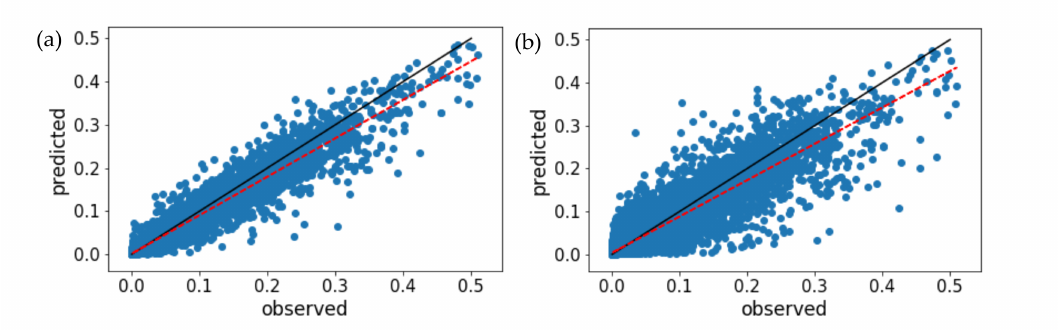
Figure 4. Prediction for 16:50 on 22 December 2018: ( a ) 10 input frames of PredRNN ++ ; ( b ) 1-h prediction of PredRNN ++ ; ( c ) observed reflectivity, ground truth of ( b ); ( d ) observed reflectivity greater than 20 dBZ, used as “truth” compared to ( e ); ( e ) 1-h prediction of ENCAST.